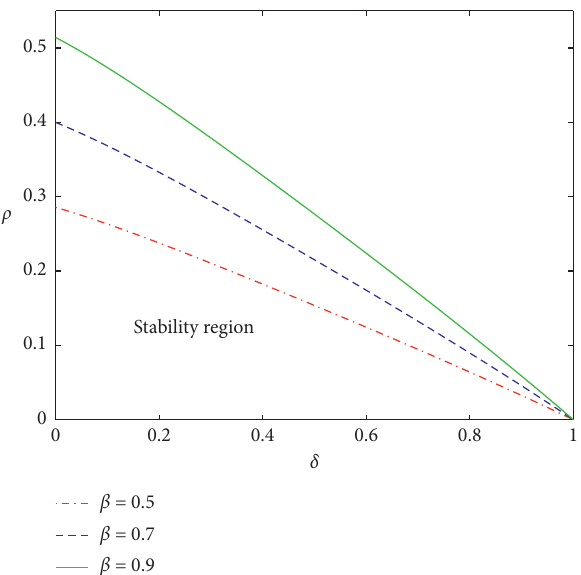
Figure 7: The stability region in the ( δ , ρ ) -plane of Nash equilibrium point E